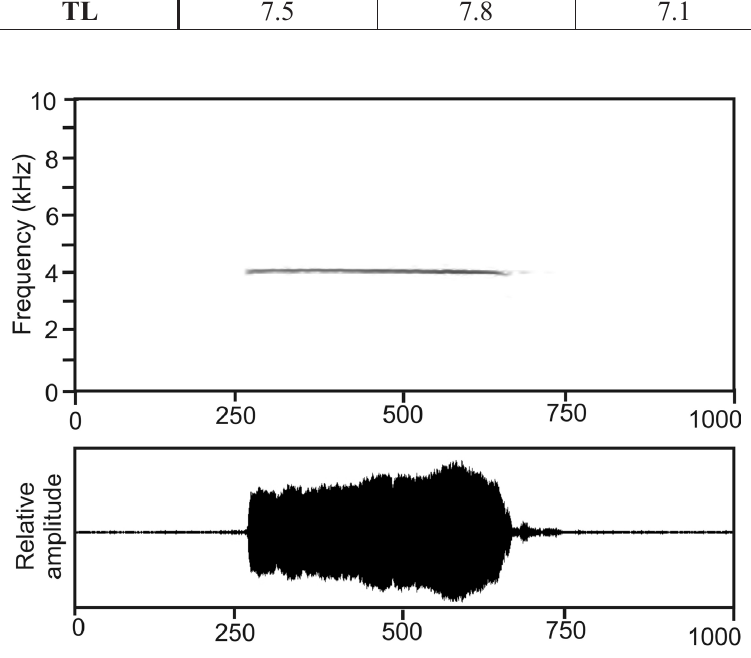
Fig. 2. Audiospectrogram and corresponding oscillogram of the advertisement call of the holotype of Platypelis ravus sp. nov. (ZSM 349/2005), recorded at Camp Simpona, Marojejy National Park, on 15 February 2005 (19:20 h) at 21.1°C air